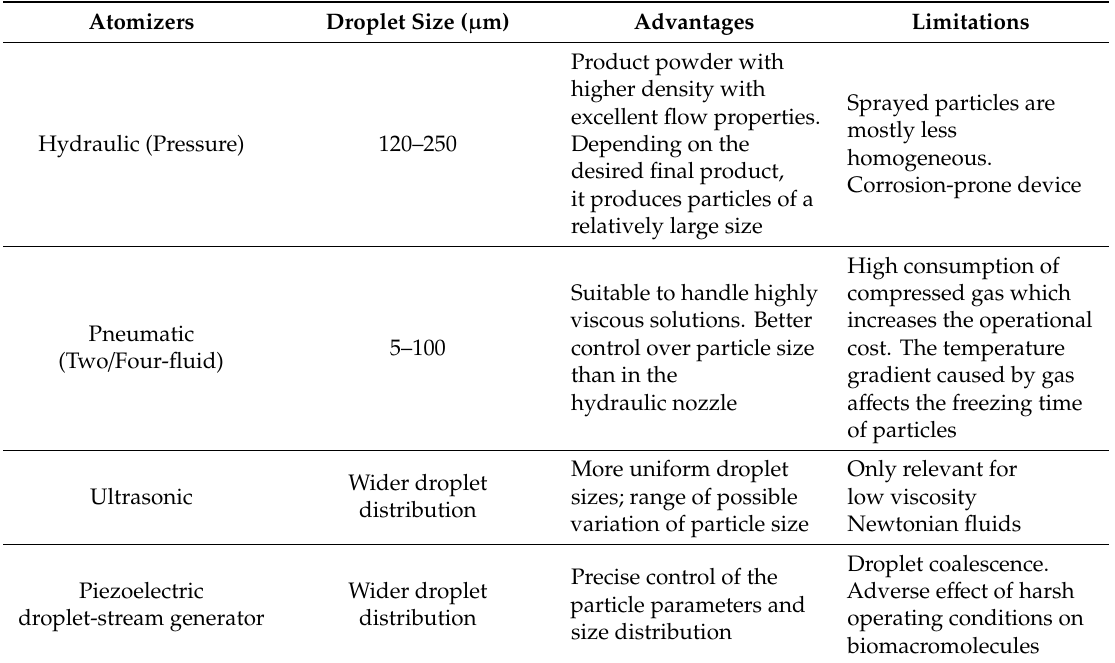
Table 2. Lists of di ff erent types of atomizers used in